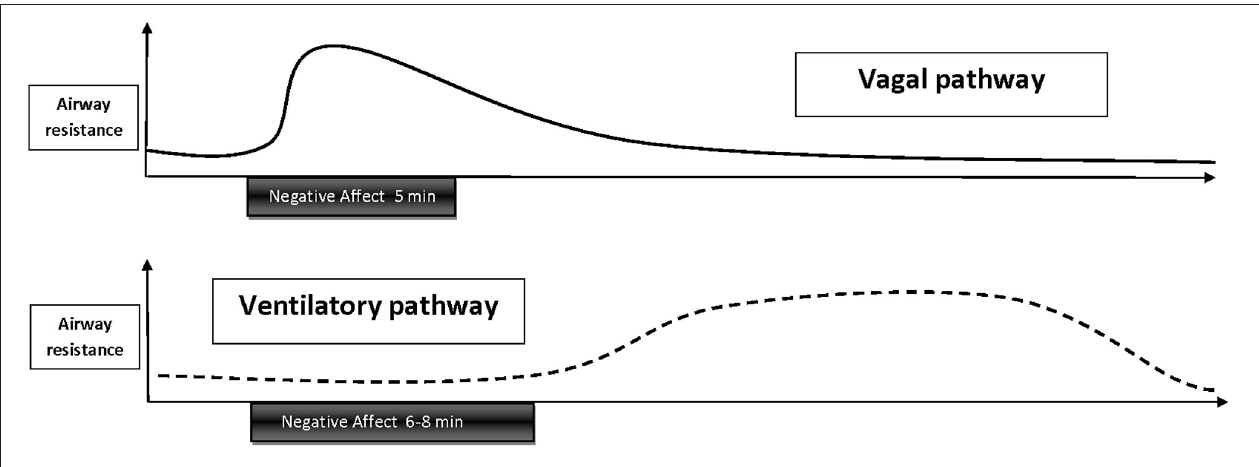
FIGURE 2 | Schematic depiction of temporal trajectories of emotion-induced airway responses that are thought to be mediated by vagal excitation or ventilatory influences. Vagally mediated responses have a fast onset, gradually decay throughout emotional stimulation, and subside within 1–2min following stimulus off-set. Hypothesized airway